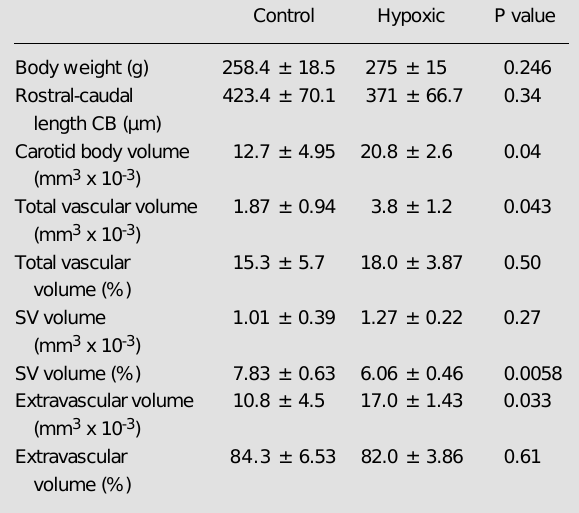
Table 1 - Dimensions of control and hypoxic rat carotid bodies (CB). Total vascular, small vessel (SV) and extravascular volumes are also expressed as a percentage of the total volume of the organ. Values are reported as means ± SD for carotid bodies of 5 control and 3 hypoxic rats. P values were determined by Student’s un- paired t